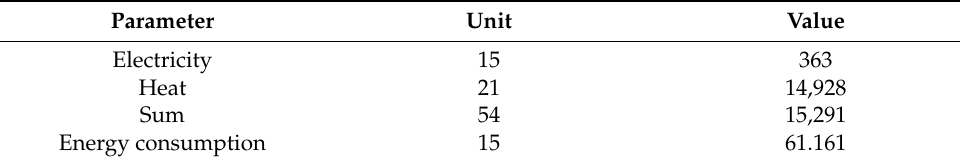
Table 13. Energy demand and energy consumption of the S428.CS dryer.